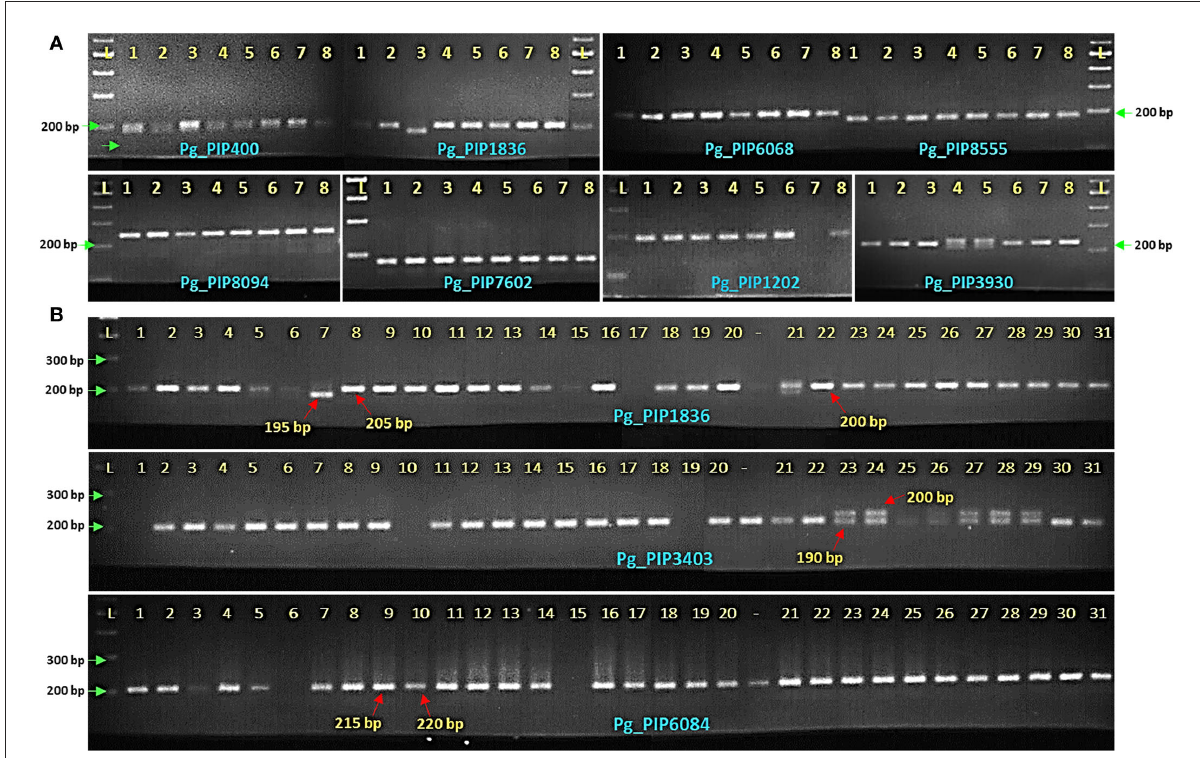
FIGURE4 Allelic differences for PIP markers when validated on eight pomegranate genotypes (A) , 31 genotypes using PIP markers Pg_PIP1836, 3403, and 6084 on 3% metaphor gels (B) (Lane L-100 bp DNA ladder, lanes 1–8, eight genotypes as mentioned in the Section Materials and methods, lanes 1–31, genotypes as mentioned in Table 1, lane-, genotypes not considered for analysis).